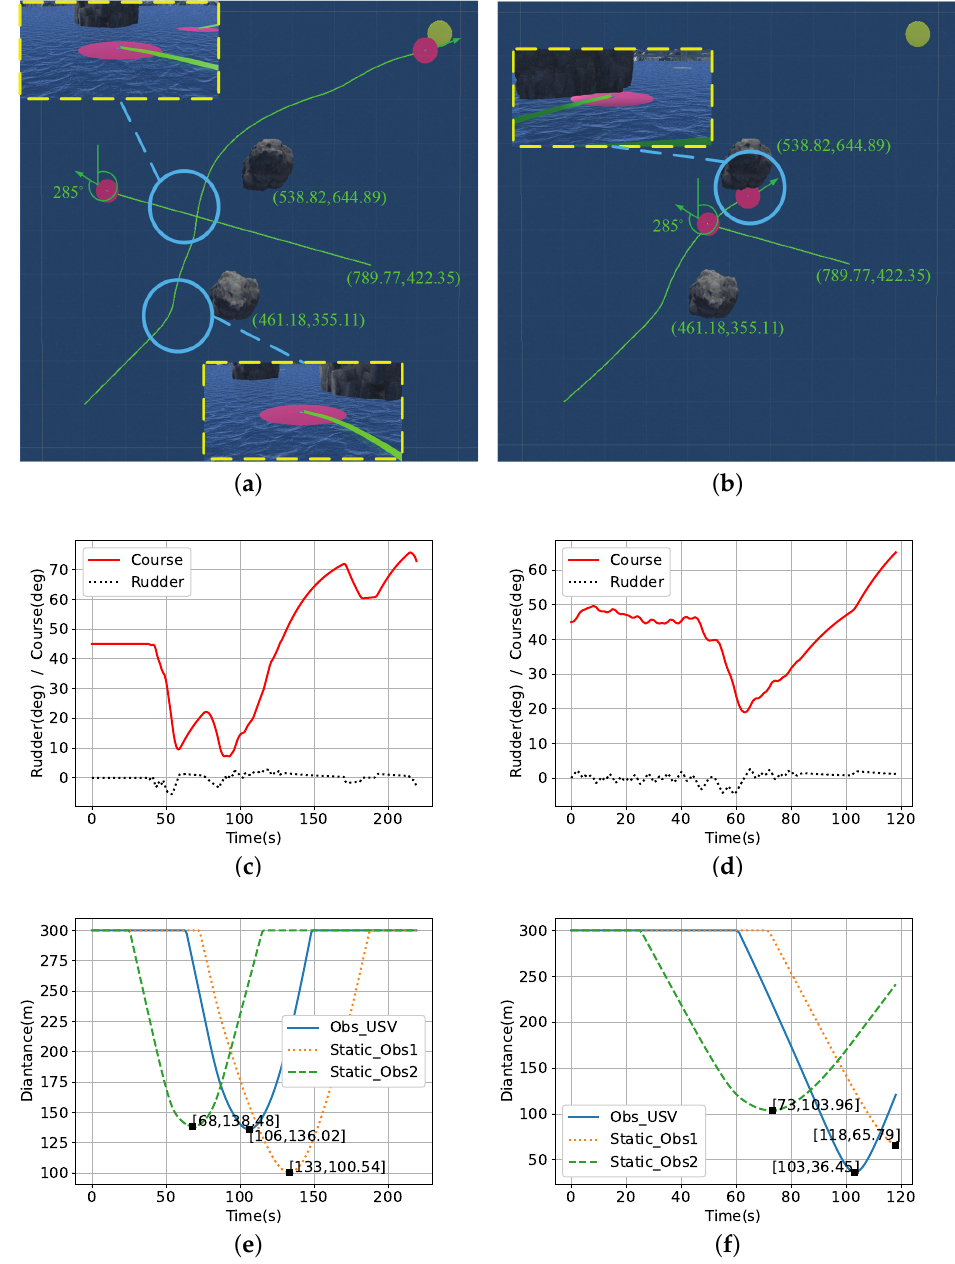
Figure 13. Encounter situation 3. ( a ) Path planned by DRLCA; ( b ) Path planned by DQN; ( c ) Course and rudder for DRLCA; ( d ) Course and rudder for DQN; ( e ) Distance for DRLCA; ( f ) Distance for DQN. The fourth test environment is shown in Figure 14. Our USV is in the No. 4 encounter situation with the obstacle USV, and there is no interference from the static obstacles. Figure 14a,b show the effect of collision avoidance of DRLCA and DQN. The initial position of the USV O , static obstacles 1 and 2 are ( 363.80, 232.70 ) , ( 232.70, 636.20 ) , and ( 633.65, 431.90 ) . The course of obstacle USV is 27 ◦ . Figure 14c,d shows the change of rudder angle and course of collision avoidance of DRLCA and DQN. Figure 14e,f shows the distance in collision avoidance of DRLCA and DQN. The accumulated course deviation is 909.19 ◦ and 2074.92 ◦ for DRLCA and DQN. The closest distances to the three obstacles are 55.11 m, more than 300 m, and 88.98 m for DRLCA and 33.16 m, 265.91 m, and 183.41 m for